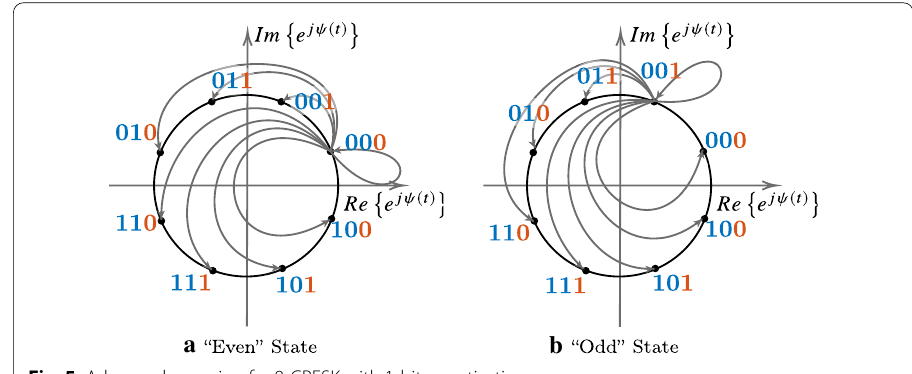
Fig. 5 Advanced mapping for 8-CPFSK with 1-bit quantization